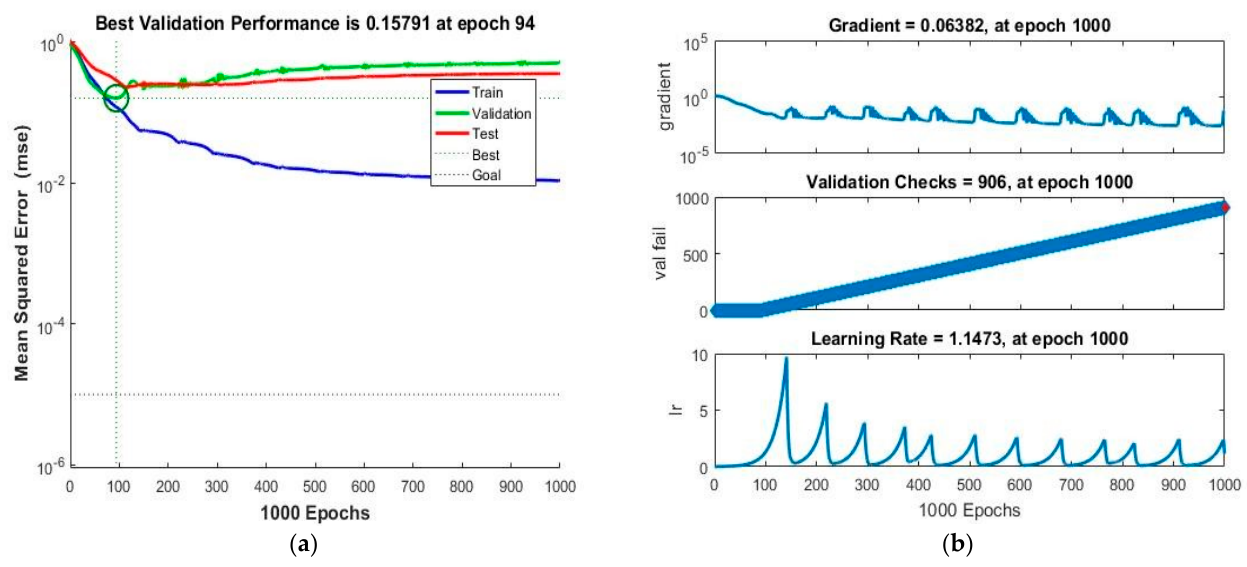
Figure 6. ( a ) Network Learning Error; ( b ) Progress of the training state. Table 5. Performance results of the network in analyzing the measurement results of the sampled oils. Sample Class Learning